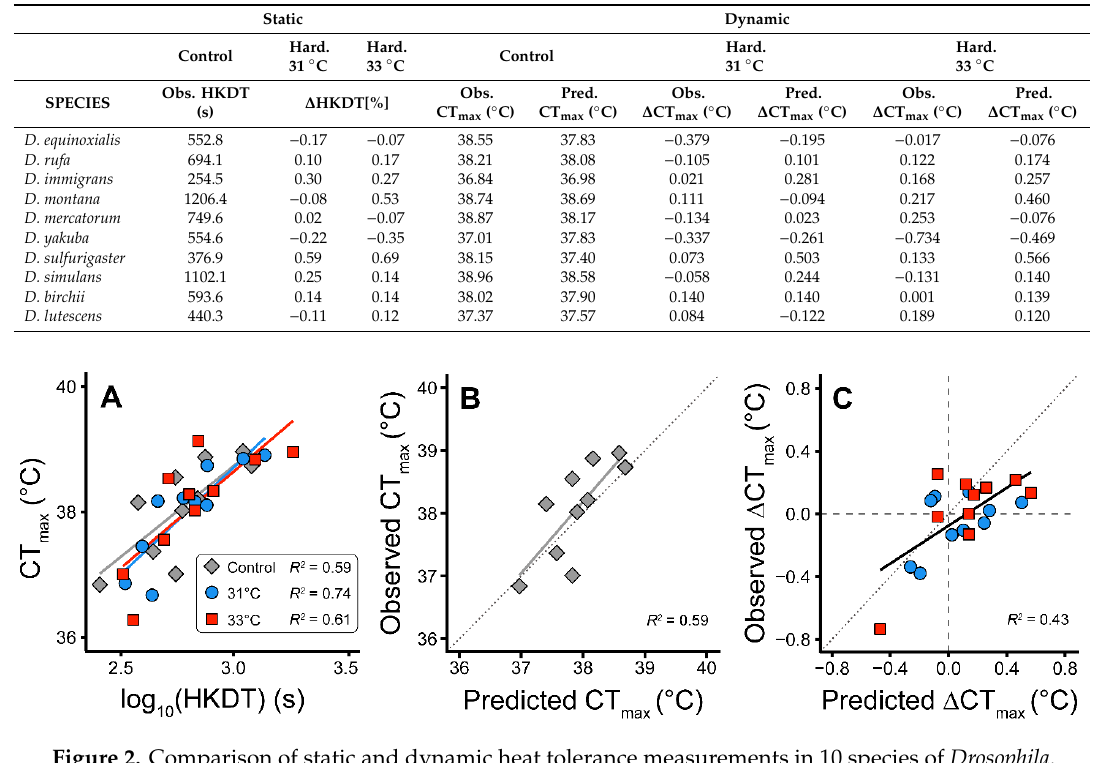
Table 2. Observed (Obs.) and predicted (Pred.) estimates of heat tolerance in 10 Drosophila species with and without prior heat hardening. Heat tolerance in static assays was measured as heat knockdown time (HKDT) at 38 °C and effects of heat hardening at 31 °C or 33 °C are reported as the % change in HKDT. Heat tolerance in the dynamic assay was measured as the temperature of heat knockdown (CT max ) during a ramp test with a temperature increase of 0.1 ◦ C min − 1 . The e ff ects of heat hardening in dynamic tests are reported as the absolute change in CT max from the control. Data from the dynamic assays are compared to predicted estimates of CT max modelled from the static HKDT (see main text for further explanation). CT max data predicted from the static measurements are shown in italics and statistically significant hardening e ff ects are underlined and in bold.